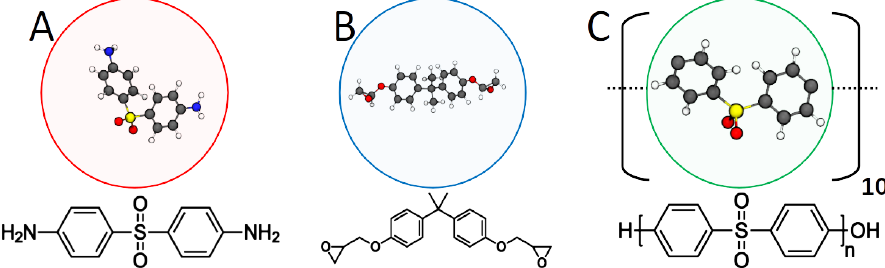
Figure 1. Coarse-grained representations of 44DDS ( A ), DGEBA ( B ), and PES ( C ) repeat units. The amines ( A ) can bond to up to four epoxies ( B ), which can each bond to up to two amines. All toughener molecules are linear 10-mers of ( C